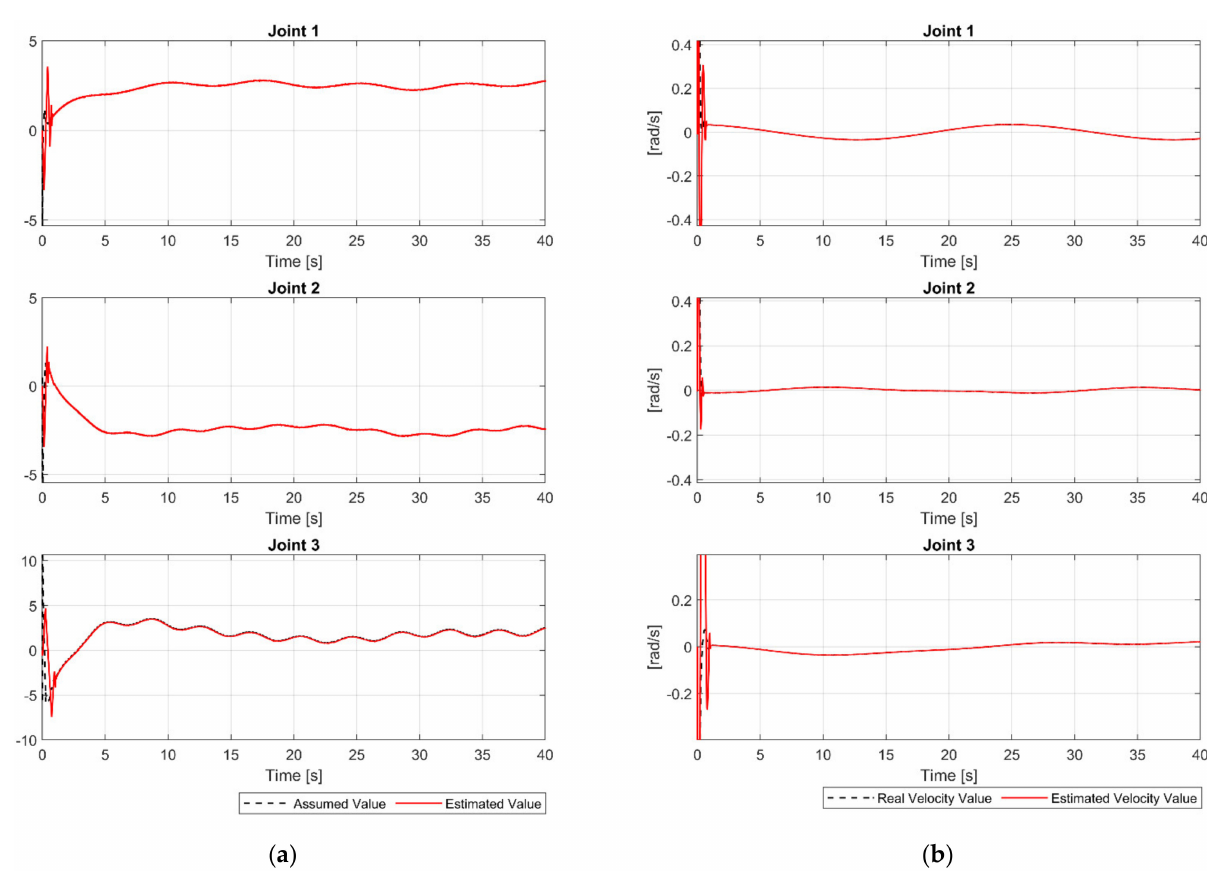
Figure 3. ( a ) The assumed value of uncertainty and its estimated value at joints; ( b ) the real velocity value and its estimated value at